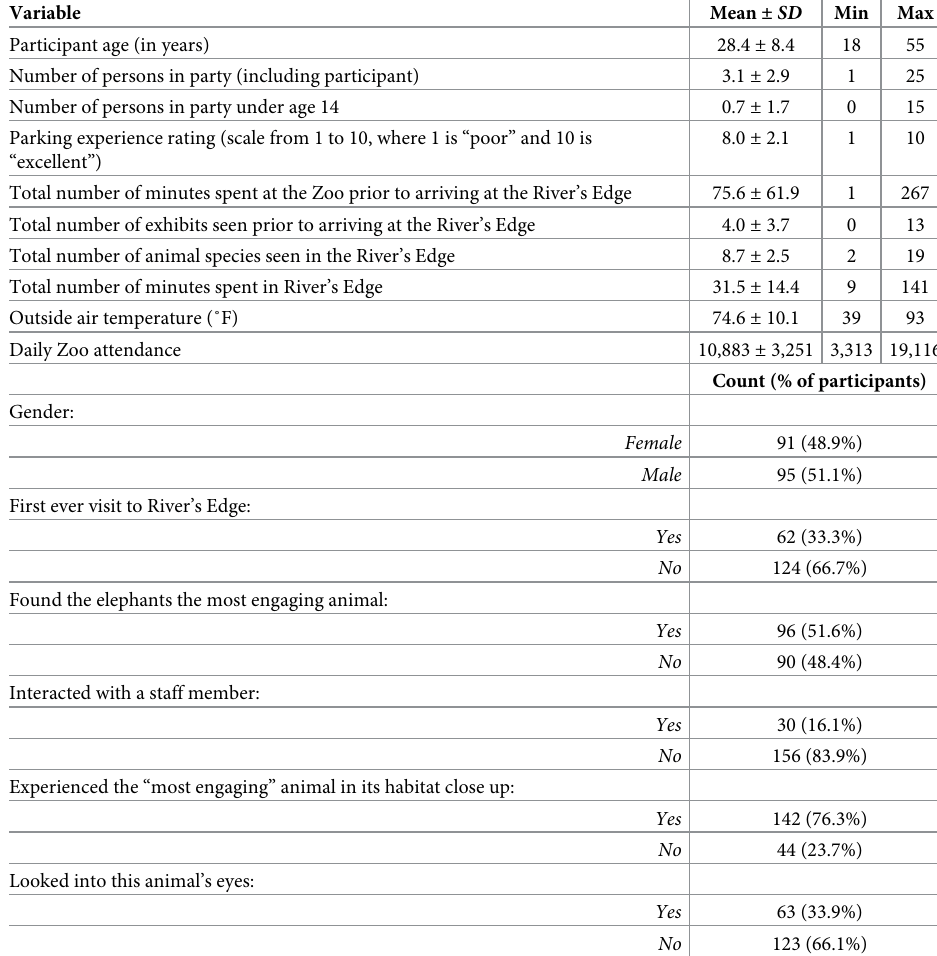
marginally significant for diastolic blood pressure (F = 3.21, p = 0.075). Males had signifi- 1,179 cantly higher systolic blood pressure and marginally higher diastolic blood pressure compared to females (F = 60.35, p < 0.0001 and F = 3.65, p = 0.058, respectively). Age was signifi- 1,179 1,179 cantly associated with both systolic and diastolic blood pressure: higher blood pressure was associated with increasing age (r = 0.4565, t = 3.80, p = 0.0002 and r = 0.2763, t = 3.16, 179 179 p = 0.0018, for systolic and diastolic blood pressures, respectively). Diastolic blood pressure was also affected by air temperature and party size. Lower diastolic values were associated with higher air temperatures (r = -0.1625, t = -2.30, p = 0.023) and larger party sizes (r = -0.5991, 179 t = -2.14", p = 0.034). 179 During their River’s Edge visit, 23% of the 186 participants shifted from a higher systolic blood pressure category to a lower systolic blood pressure category with 17% of the total partic- ipants shifting down to the normal category ( x 2 = 4.004, df = 2, p = 0.135). Additionally, 15% of participants shifted from a higher diastolic blood pressure category to the normal diastolic blood pressure category ( x 2 = 2.464, df = 1, p = 0.116). We defined categories based on the guidelines of the American Heart Association, Inc. [52]. There was an increase in the total